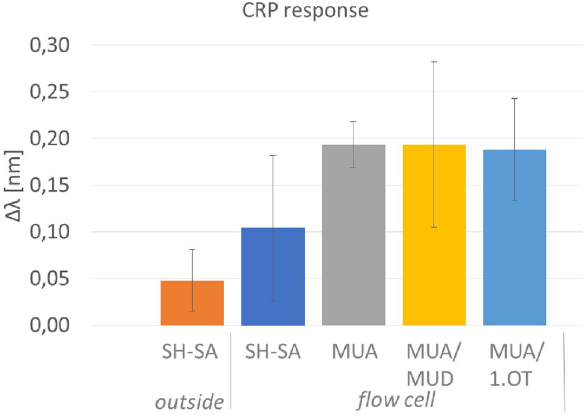
Figure 5. Sensor response Δλ in nm for 31 µg/ml CRP with differently immobilized capture antibody shown. Each value is a mean value of at least 3 independent measurements, error bars are standard